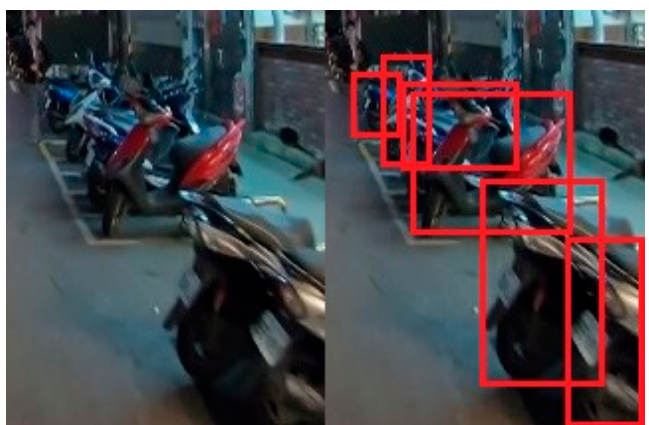
Figure 7. Occluded motorbikes with clearly visible outlines and noteworthy features. Left : Part cropped from unlabeled data. Right : Part cropped from labeled data.